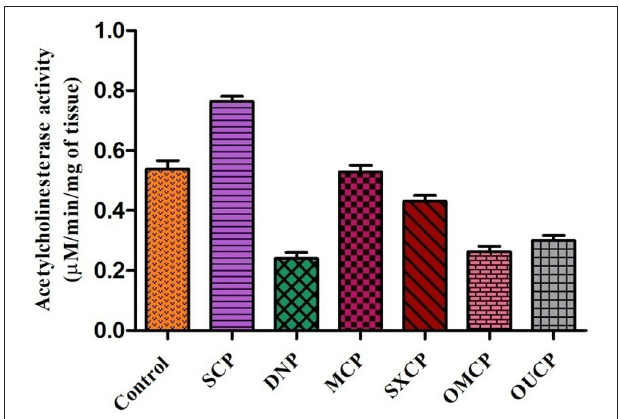
FIGURE 11 | AChE inhibitory potential of different extracts and standard